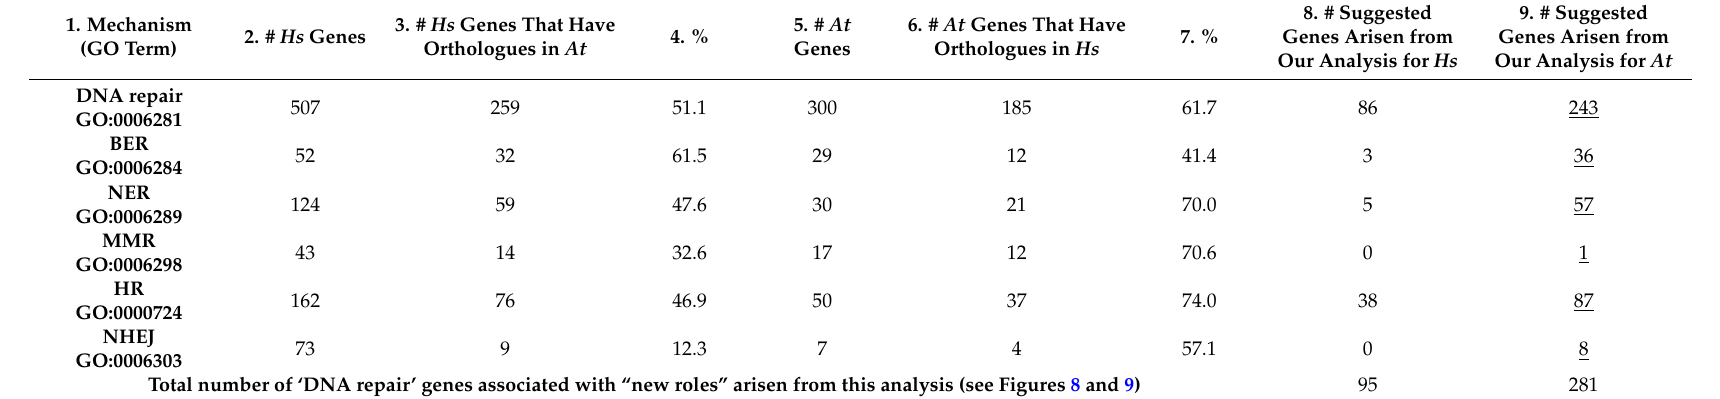
Table 7. Quantitative results obtained from the comparative analysis of DNA repair mechanisms in plants and humans. In the first column, the various ‘lemmas’ (annotations) for DNA repair and its subpathways are presented, accompanied with the corresponding GO terms. The 2nd column is referred to the number of the already characterized Homo sapiens (Hs) genes. The 3rd refers to those genes of the 2nd column that have orthologues (one or more) in Arabidopsis thaliana (At). The 4th column is just the percentage (those that have orthologues/all genes). Correspondingly, 5th–7th columns refer to Arabidopsis thaliana . Underlined (8th–9th column) are the ‘new’ genes identified from our analysis for Hsa and Atha respectively. BER, base excision repair. NER, nucleotide excision repair. MMR, mismatch repair. HR, homologous recombination. NHEJ, non-homologous end